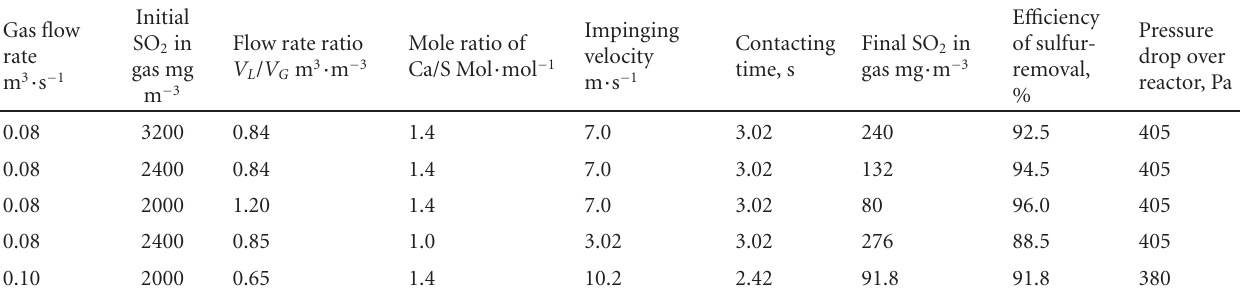
Table 1: Typical operation data of the impinging stream FGD